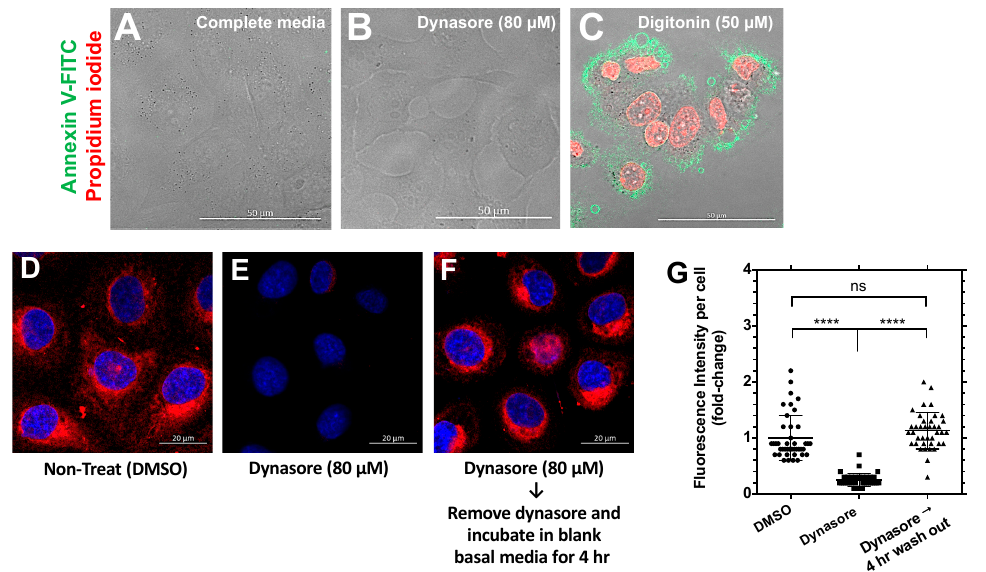
Figure A3. Dynasore inhibits endocytosis of LP-A96 without cytotoxicity. ( A – C ) Cell viability under each treatment was visualized using annexin V and propidium iodide. Cells were incubated for 1 h with complete media, 80 µ M dynasore, or 50 µ M digitonin. Cells treated with dynasore did not experience cell death. ( D – F ) Endocytosis of LP-A96 is restored after dynasore has been removed. Cells pre-treated with ( D ) DMSO or ( E ) dynasore were further incubated with 1 µ M rhodamine-labeled LP-A96 for 15 min and imaged. ( F ) Cells incubated for additional 4 h in basal media after dynasore was removed were further incubated with 1 µ M rhodamine-labeled LP-A96 for 15 min and imaged. ( G ) Fluorescence intensity changes show restoration of LP-A96 endocytosis after 4 h. **** p < 0.0001, ns: non-significant. Mean ± SD.